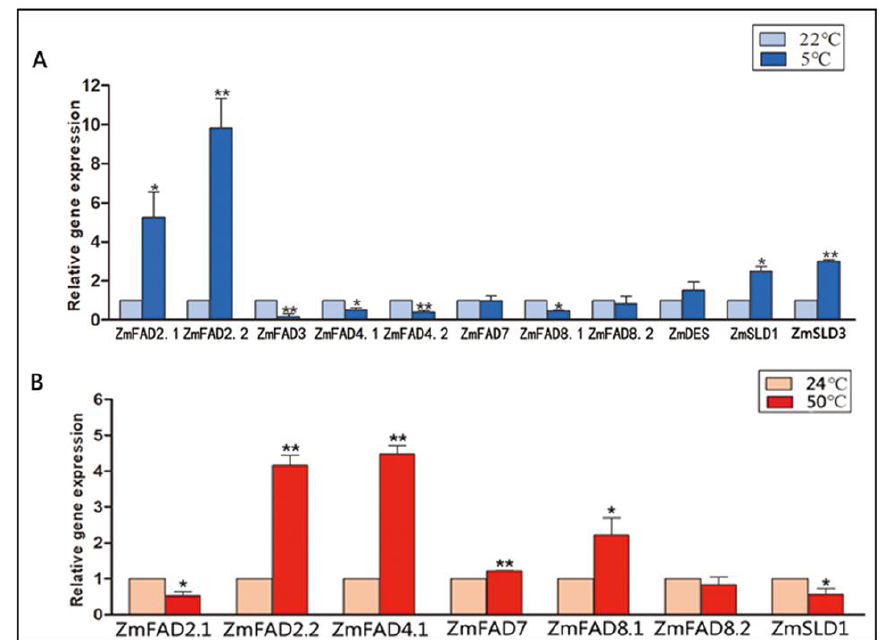
Figure 8. The qRT-PCR analysis of the expression profiles of ZmFADs in response to cold ( A ) and heat; ( B ) treatment in maize leaves.